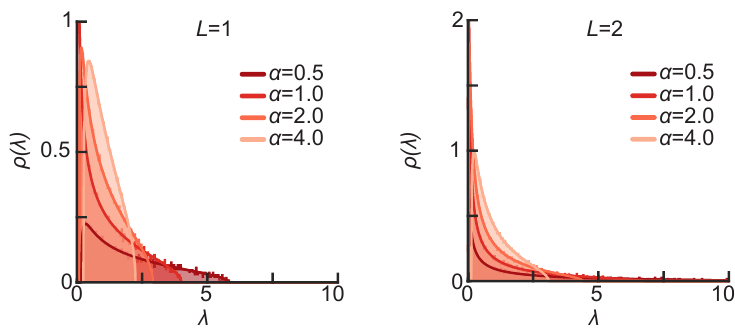
= ··· = α = α , indicated by L 1